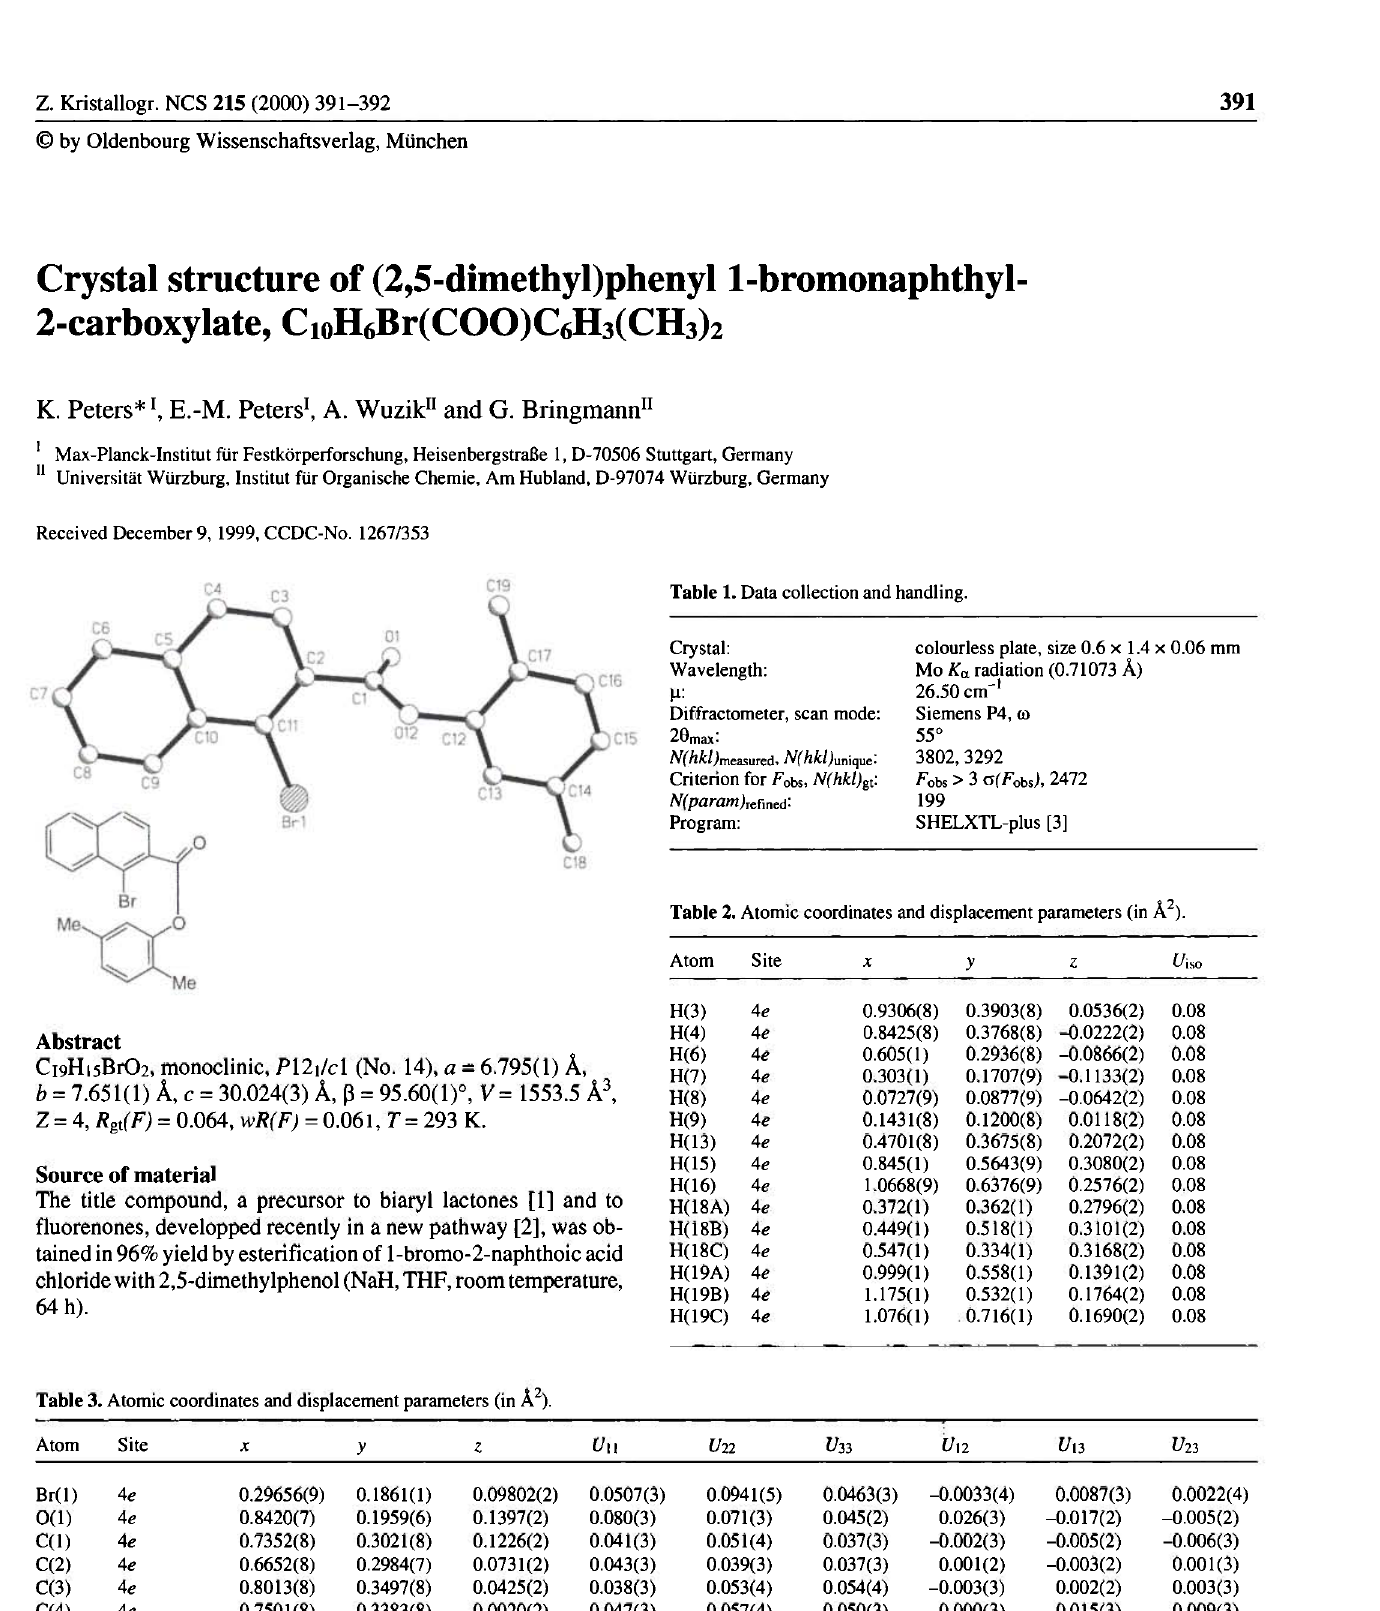
Table 3. Atomic coordinates and displacement parameters (in A 2